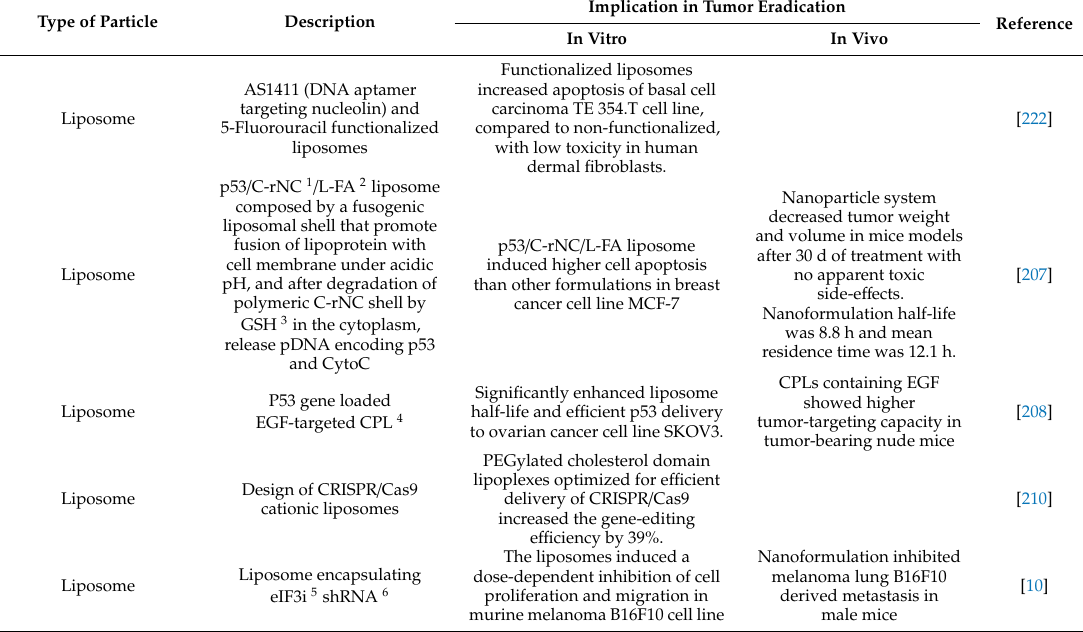
Table 3. Application of liposomes and solid-liquid nanoparticles in cancer